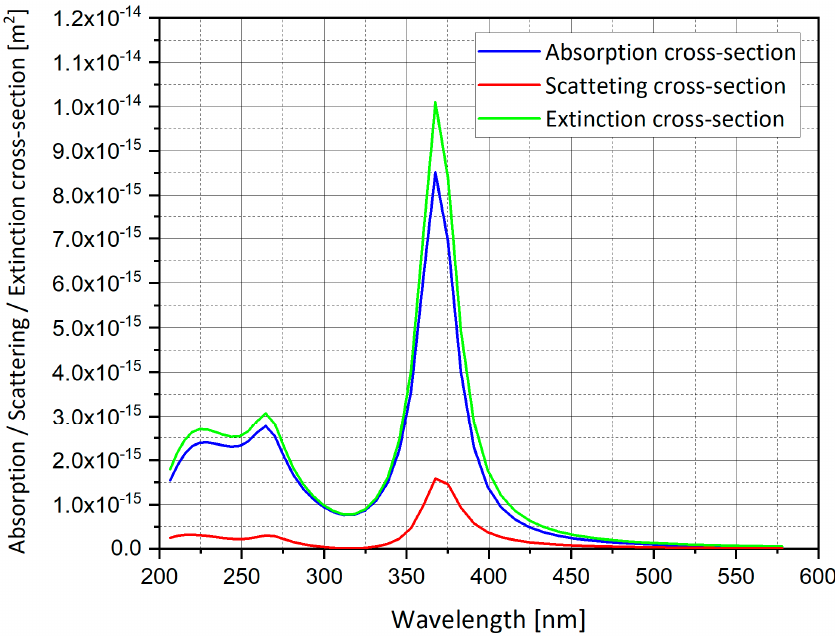
Figure 3. Absorption, scattering and extinction cross-section of silver (Ag) spheroid nano-particle.